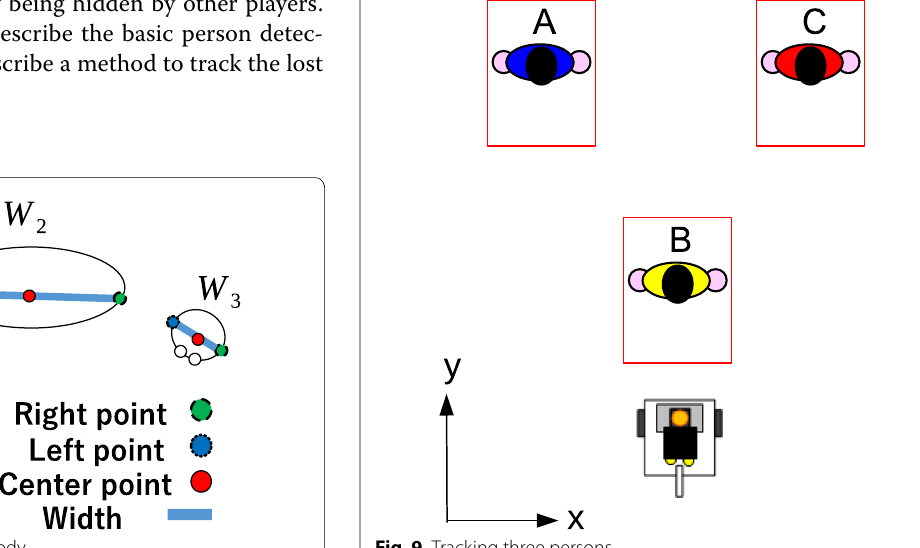
Fig. 8 Determination of the body Fig. 9 Tracking three